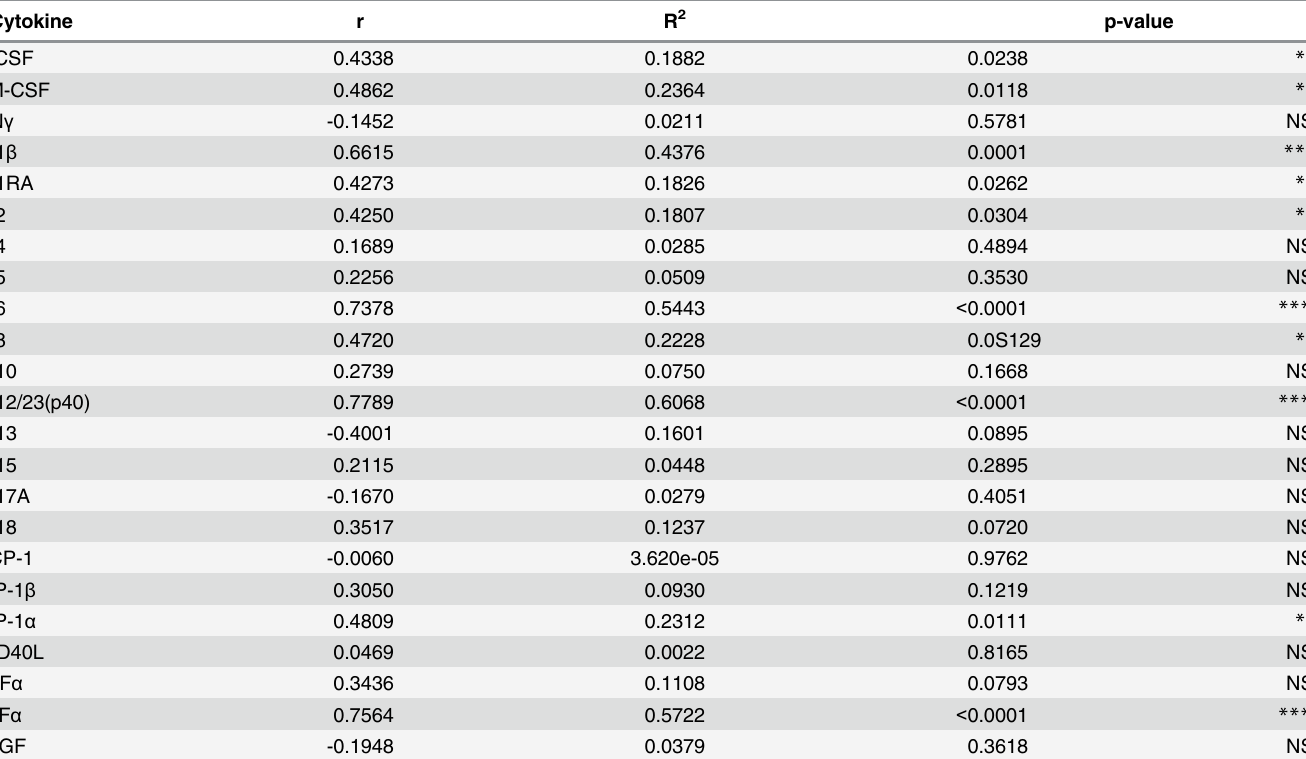
Table 1. Correlation values between neutrophil oxidative burst capacity and 23 cytokines, chemokines and growth factors. Cytokine r